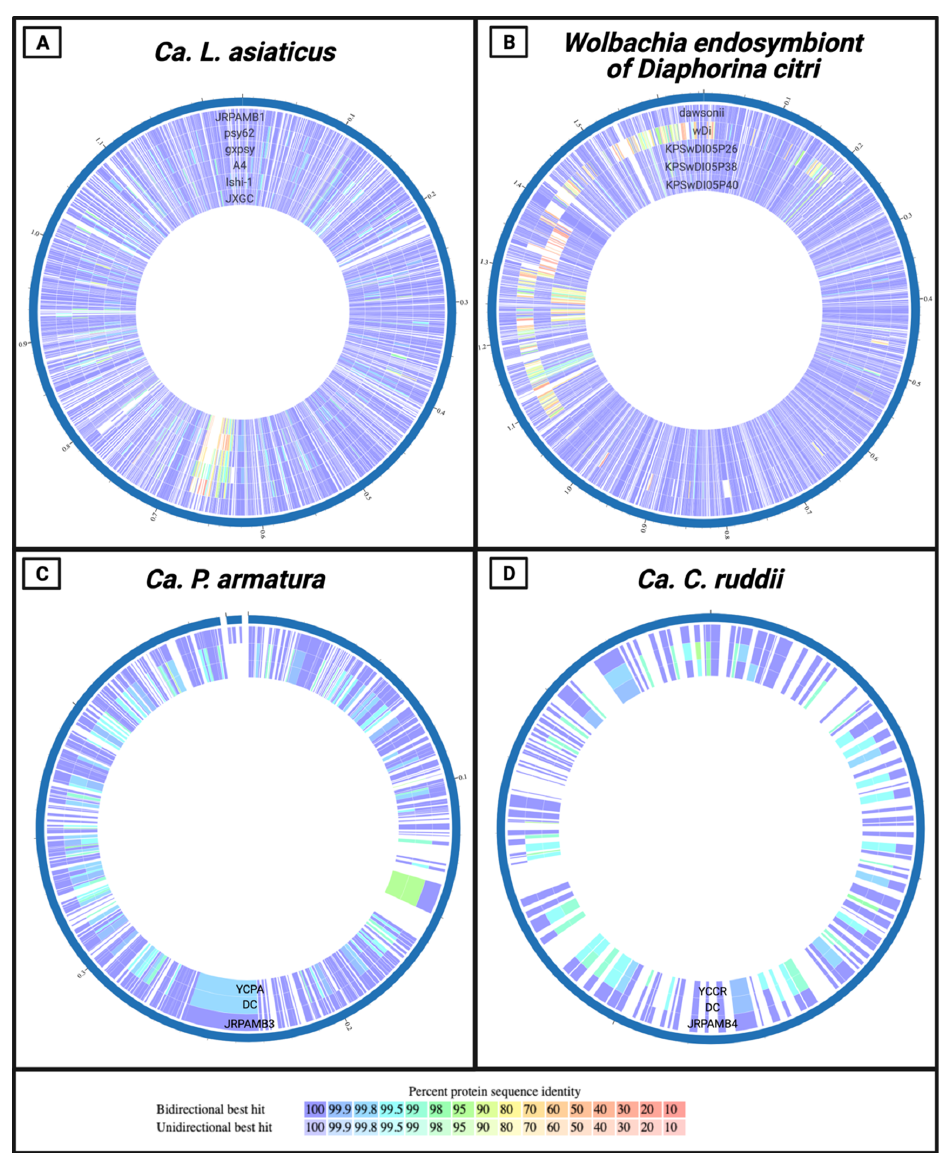
Figure 3. Circos plots comparing the predicted proteomes of our JRPAMB strains 1–4 on the outermost ring to the current NCBI depositions. ( A ) The genome of Ca . Liberibacter asiaticus JRPAMB1 against (outer to inner) str. psy62, str. gxpsy, str. A4, str. Ishi-1, and str. JXGC, respectively. ( B ) Wolbachia dawsonii contigs against wACP3, KPSwDI05P26, KPSwDI05P38, and KPSwDI05P40. ( C ) Ca . Profftella armatura JRPAMB3 against NCBI strains DC and YCPA. ( D ) Ca . Carsonella ruddii strain JRPAMB4 vs. strains DC and YCCR. Created with